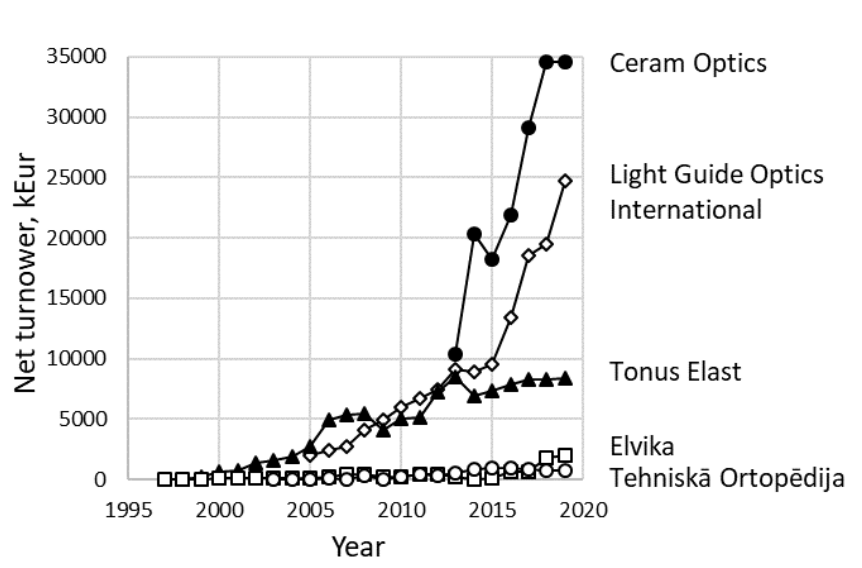
Fig. 7. Turnover of the top five MD manufacturer enterprises in Latvia, 1996–2019 (the author’s calculations).